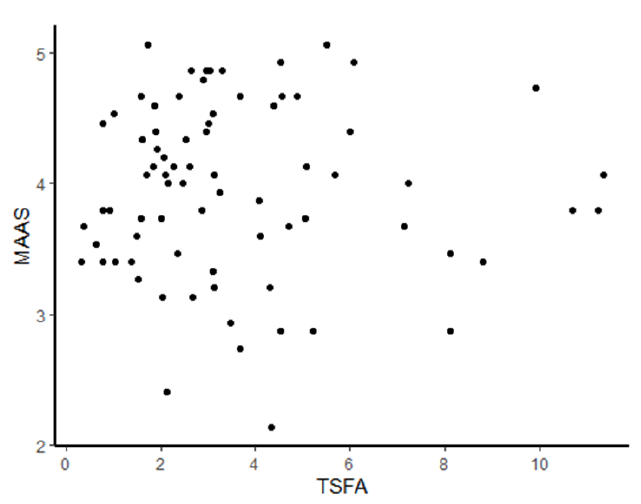
Fig.2 Scatterplot showing relationship between TSFA (Time Span of Focused Attention in minutes) and MAAS (Mindful Attention Awarenesss Score) (r = 0.04; 95% CI, -0.19 to +0.26; p = 0.74)